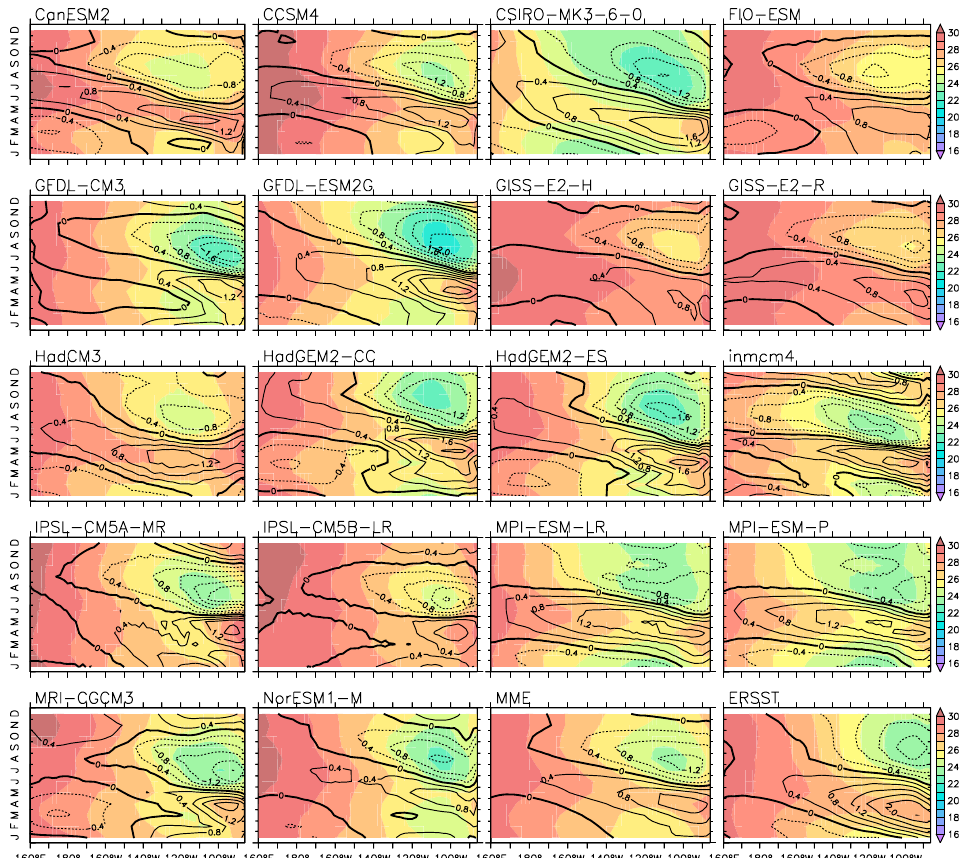
Figure 1. Seasonal cycle of sea surface temperature (SST) in the eastern equatorial Pacific (EEP). Shadings represent climatological SST, and contours represent SST anomalies relative to climatological annual mean.